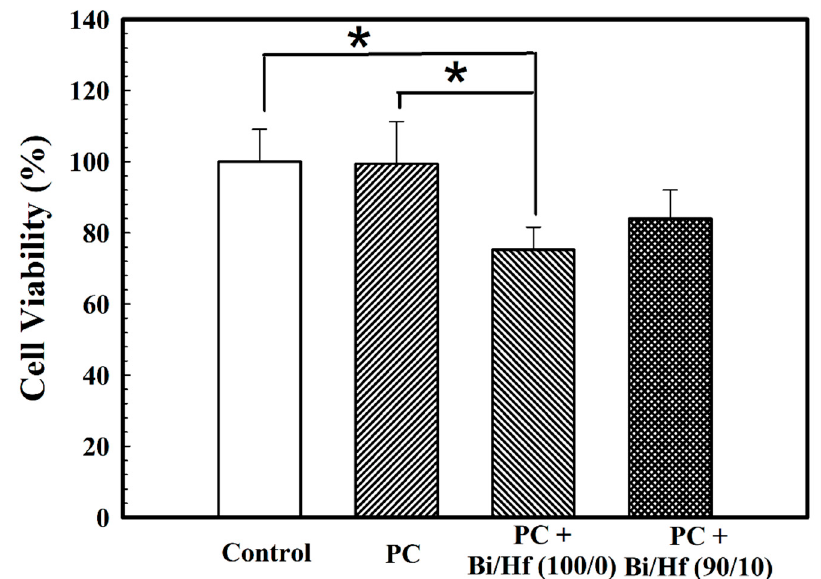
Figure 7. Cell viability of MTA-like cement containing different Bi/Hf radiopacifiers where Portland cement (PC) and polyethylene (PE) are control groups. * indicated that these two sets of samples were statistically different at a 95% confidence interval.